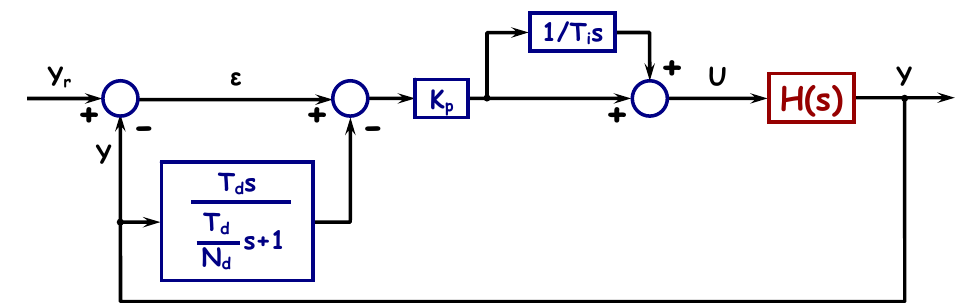
Figure 2. Regular, standard Proportional–Integral–Derivative(PID) structure (PID-R).